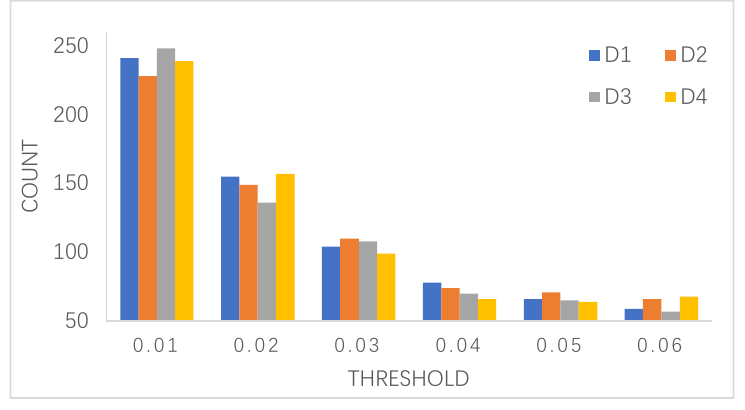
Figure 8. The number of EABMC frequent sequential patterns of 4 datasets under different minimum supports.